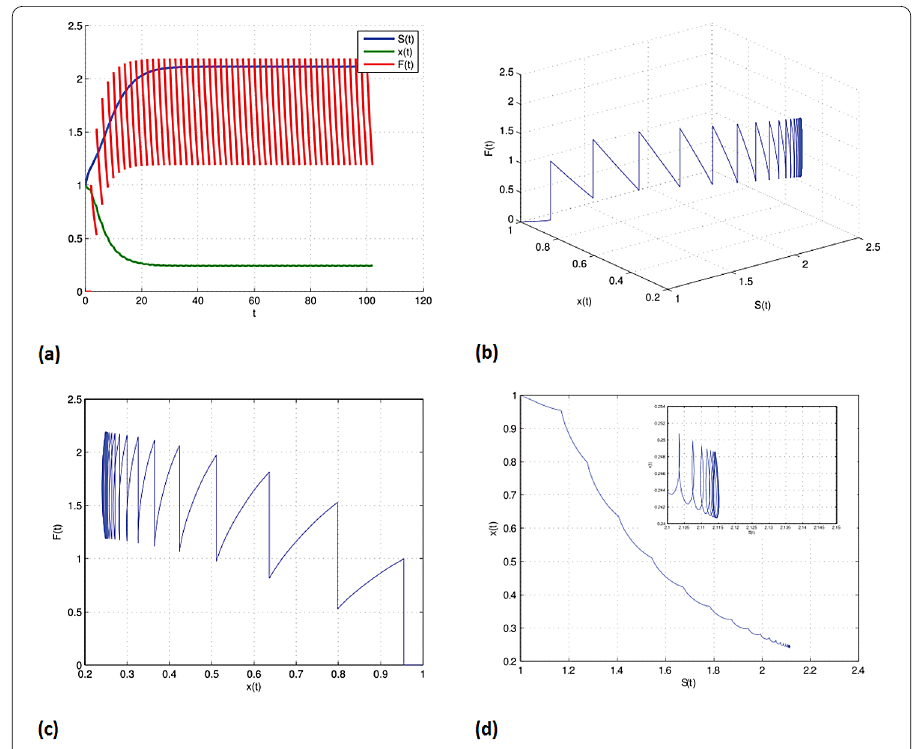
Figure 6 Dynamical behavior of solutions of system (26) with R 2 = 1.1432 > 1. (a) Time series of S ( t ), x ( t ), F ( t ). (b) Three-dimensional phase diagrams of S ( t ), x ( t ), F ( t ). (c) Phase diagrams of x ( t ), F ( t ). (d) Phase diagrams of x ( t ), S ( t ).